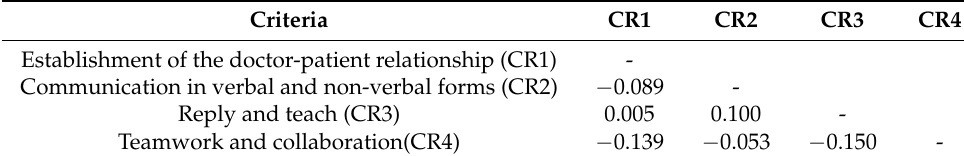
Table 13. The net influence matrix of the communication and relationship (CR) aspect.